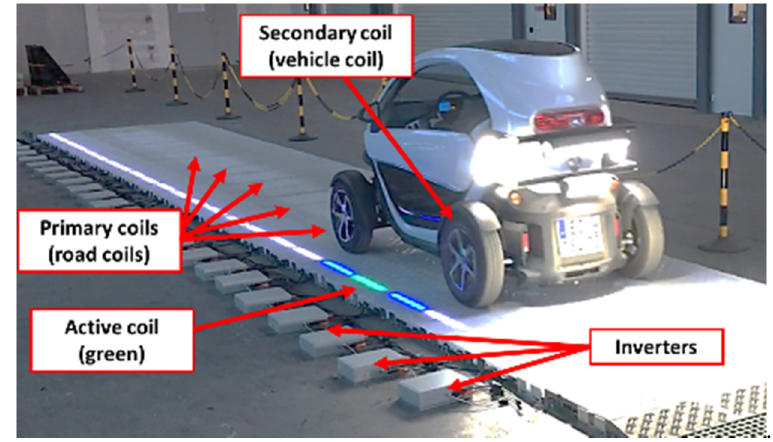
Figure 4. VEDECOM DWPT charging system test bench [30].